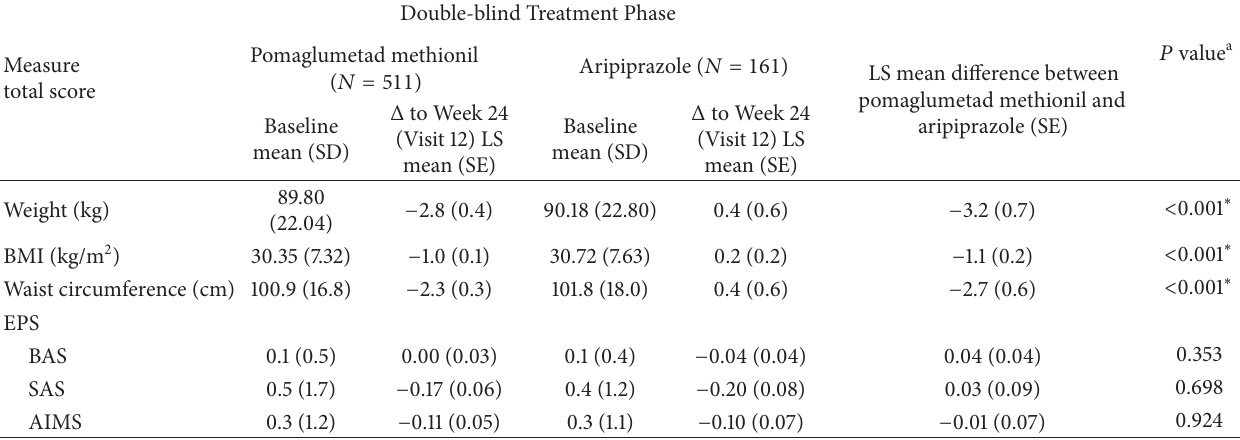
𝑃 value a Pomaglumetad methionil